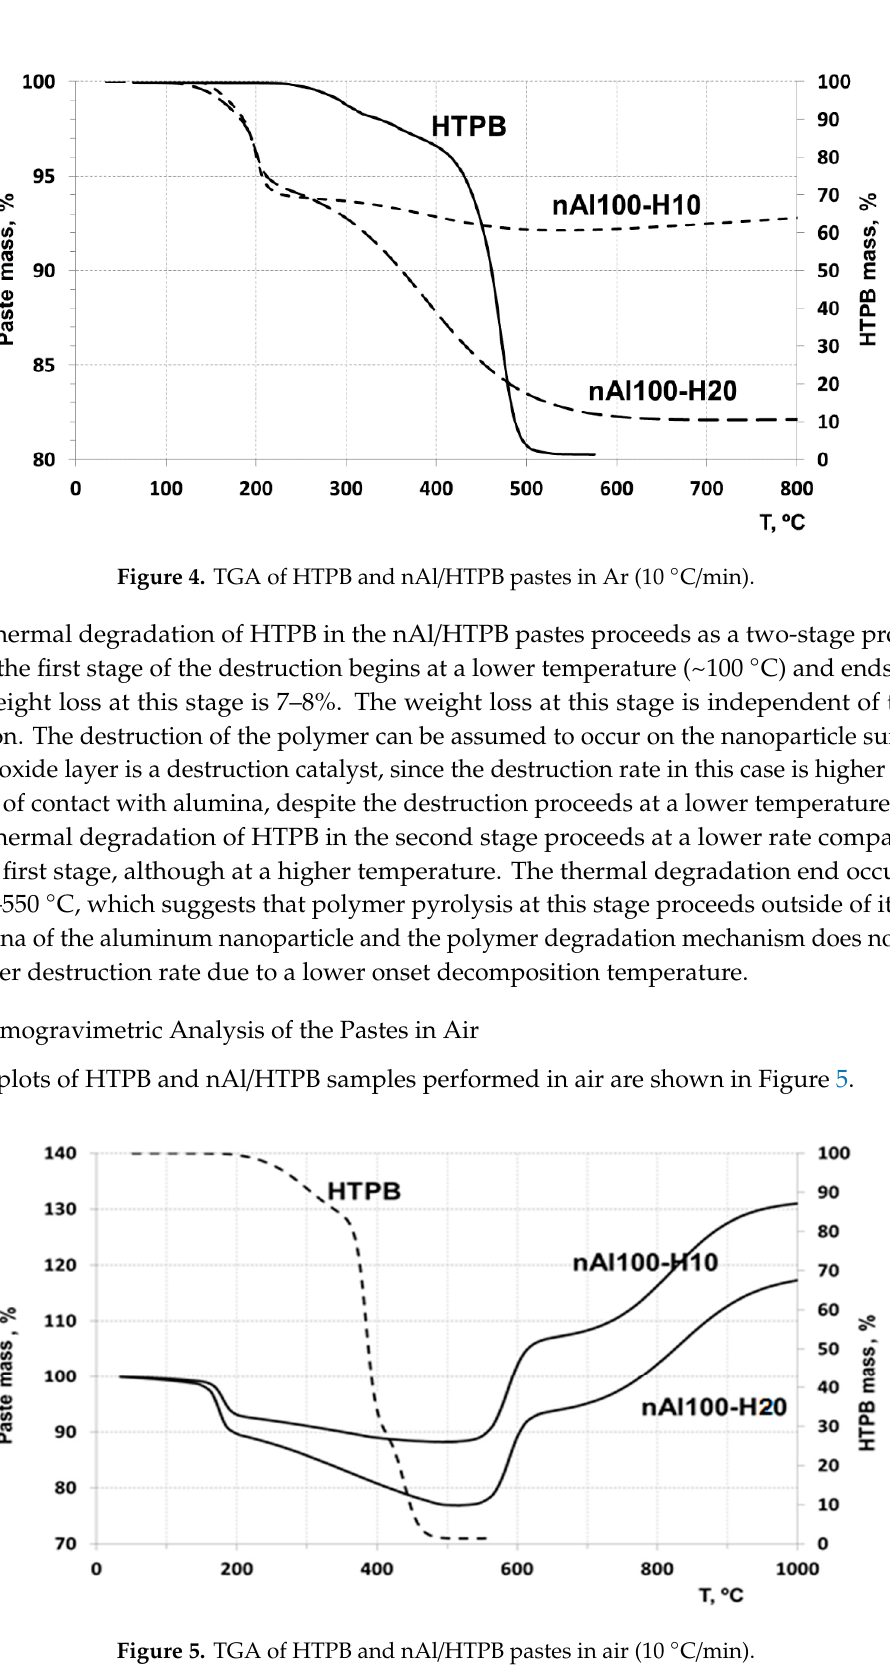
Figure 5. TGA of HTPB and nAl/HTPB pastes in air (10 °C/min).